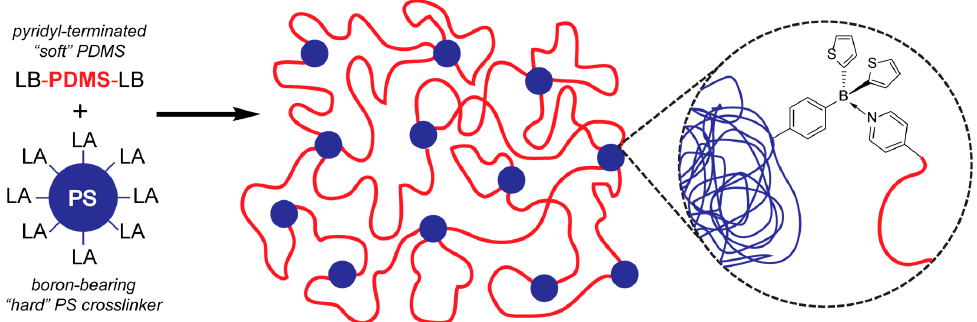
Figure 1. Schematic representation of the proposed crosslinked supramolecular network in the polystyrene/ polydimethylsiloxane (PS/PDMS) blend promoted by Lewis acid/Lewis base pairs polystyrene/polydimethylsiloxane (PS/PDMS) blend promoted by Lewis acid/Lewis base pairs (LA = Lewis acid, LB = Lewis base). (LA = Lewis acid, LB = Lewis